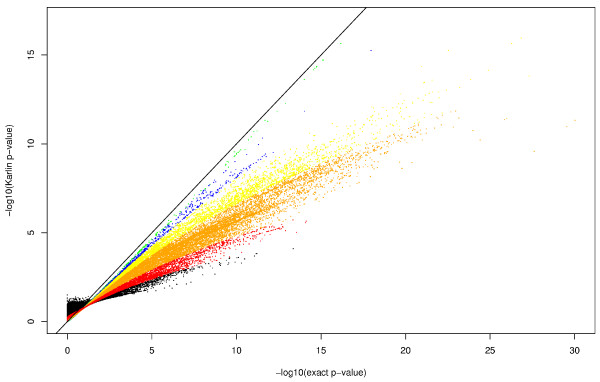
Exact p-value against Karlin ones (in log scale). Color refers to a range of sequence lengths: smaller than 100 in black (≃ 20 000 sequences), between 100 and 200 in red (≃ 40 000 sequences), between 200 and 500 in orange (≃ 90 000 sequences), between 500 and 1000 in yellow (≃ 30 000 sequences), between 1000 and 2 000 in blue (≃ 6 000 sequences) and greater than 2 000 in green (≃ 1 000 sequences). The solid line represents y = x. Range have been chosen for readability and few dots with exact p-value smaller than 10-30 are hence missing.